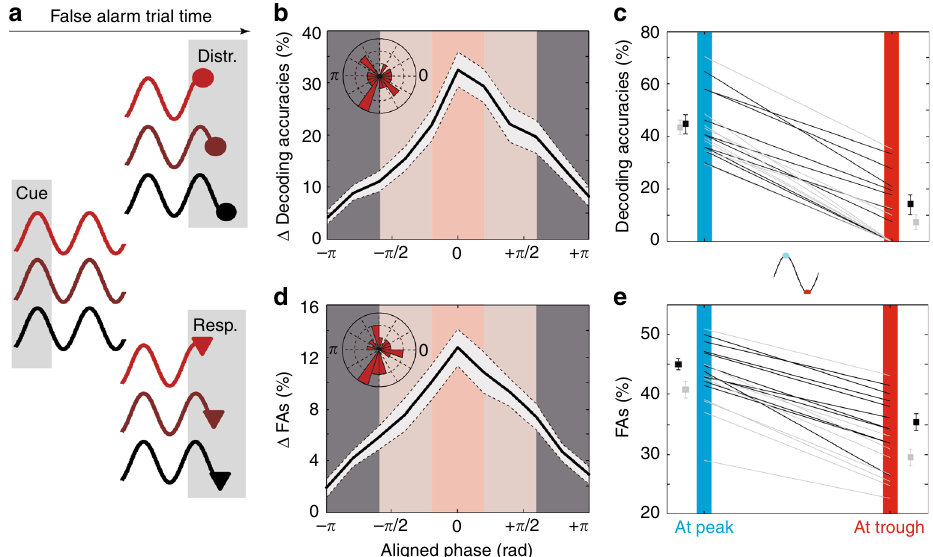
Fig. 7 PFC distractor related information and false alarm rates depend on when the DISTRACTOR is presented relative to attentional oscillation cycles. a Categorization schema of trials as a function of when the distractor (top) and behavioral response (bottom) was presented relative to attentional oscillation cycles. b Distractor related information is signi fi cantly higher in trials presented at optimal phase with respect to the attentional oscillation cycles. c Peak to trough variations in distractor related information (M1: black, M2: gray), for each session (±s.e.). d Percentage of false alarms is signi fi cantly higher in trials presented at optimal phase with respect to the attentional oscillation cycles (inset: radial distribution of phase shifts relative to cue presentation, 18 sessions). e Peak to trough variations in percentage of false alarms (M1: black, M2: gray), for each session (±s.e.). All else as in Fig. 3.